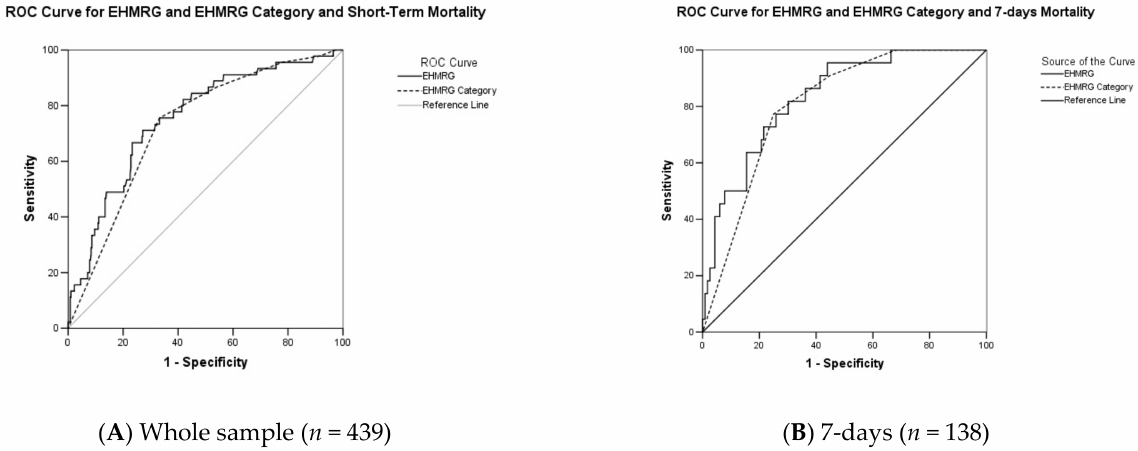
Figure 1. ROC curve analysis of continuous and categorial EHMRG for in-hospital death (panel ( A ): whole sample; panel ( B ): first 7 days of